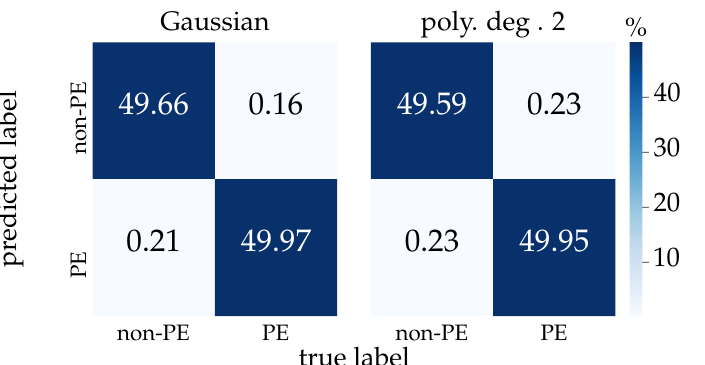
Figure 10. SVM Gaussian and second-degree polynomial kernel function confusion matrix using the validation dataset on the trained support vector classifiers.